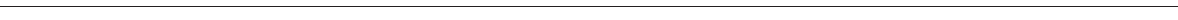
FIGURE 3 | experiment. lnc-C/EBP β lentivirus treated CD45.1 + BMCs were injected into WT mice in tail vein, and after 1 week the spleen CD45.1 cell was analyzed. (E) Flow cytometry of MDSCs in mouse spleen after injecting lnc-C/EBP β lentivirus treated CD45.1 + MDSCs. The percentage changes and the absolute cell number of CD45.1 + MDSC subsets were compared ( n = 6). (F) Confocal microscopy of CD45.1 + cells in spleen. Green, CD45.1; blue, DAPI; NC, isotypic Ab. Scale bars = 100 µ m. kdLNC, lentivirus/ lnc-C/EBP β shRNA; oeLNC, lentivirus/ lnc-C/EBP β ; kdNC and oeNC, control lentiviruses. Flow cytometry in (B,E) is a representative of at least three experiments. Absolute number = total CD45.1 + cell number in spleen or tumor × percentage of CD45.1 + MDSC subsets. Two-tailed, paired T -test was used in (B,D) . * p < 0.05; ** p < 0.05; NS, no